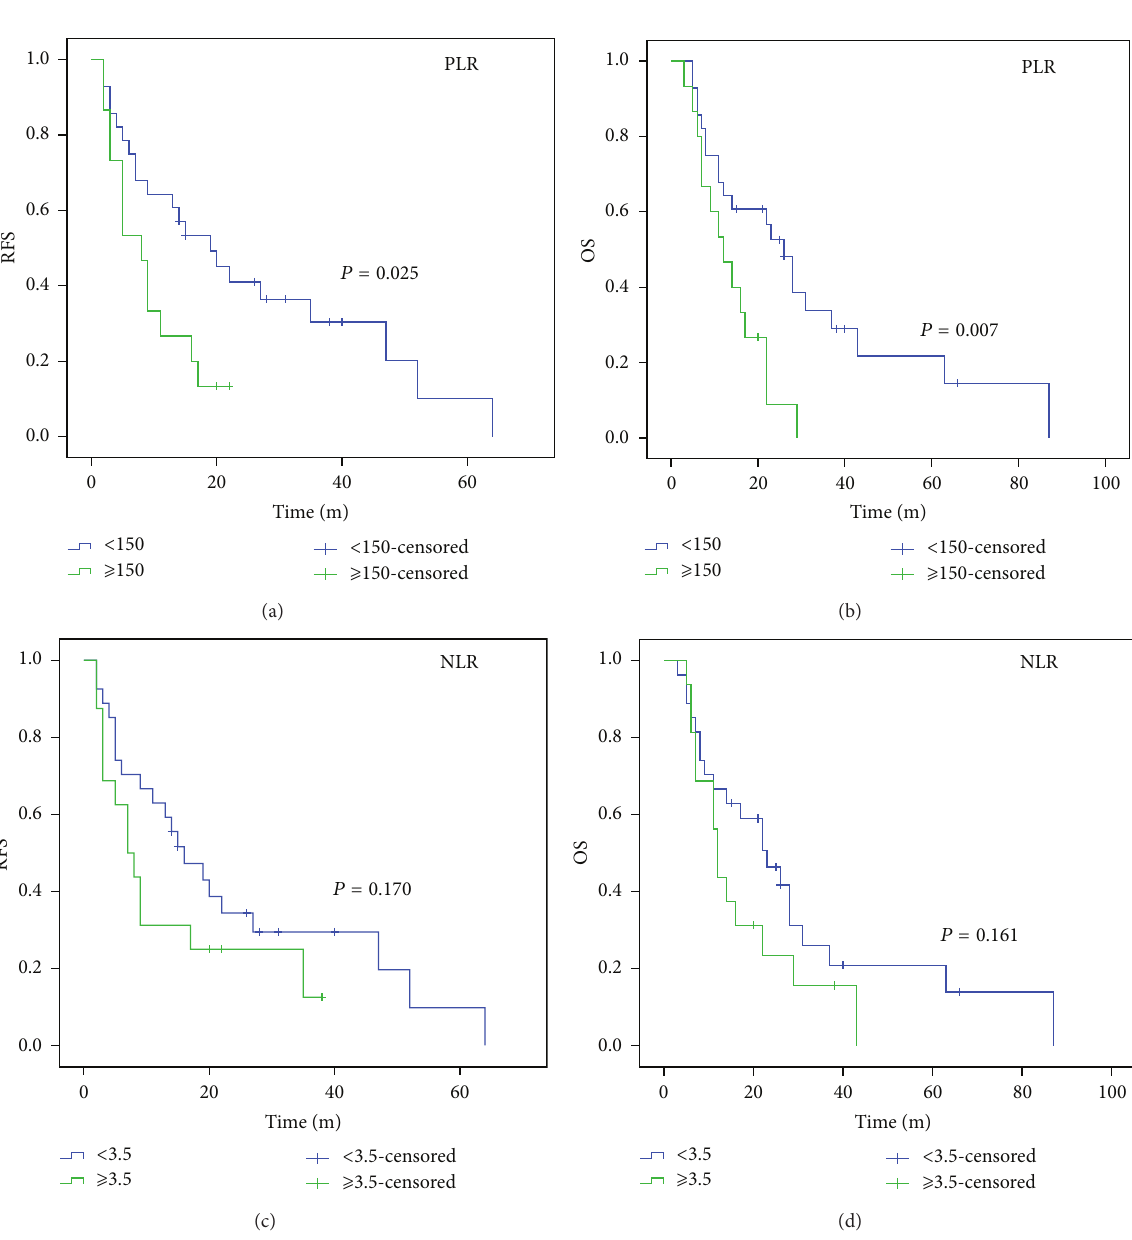
Figure 2: RFS (a) and OS (b) in PLR categories. RFS (c) and OS (d) in NLR categories. Patients with PLR ≥ 150 had significantly poorer RFS (13.3% versus 25.0%, 𝑃 = 0.025 ) (a) and OS (6.7% versus 25.0%, 𝑃 = 0.007 ) (b) compared to patients with PLR < 150. However, RFS (22.2% versus 18.8%, 𝑃 = 0.170 ) (c) and OS (22.2% versus 12.5%, 𝑃 = 0.161 ) did not differ according to NLR categories ((c) and